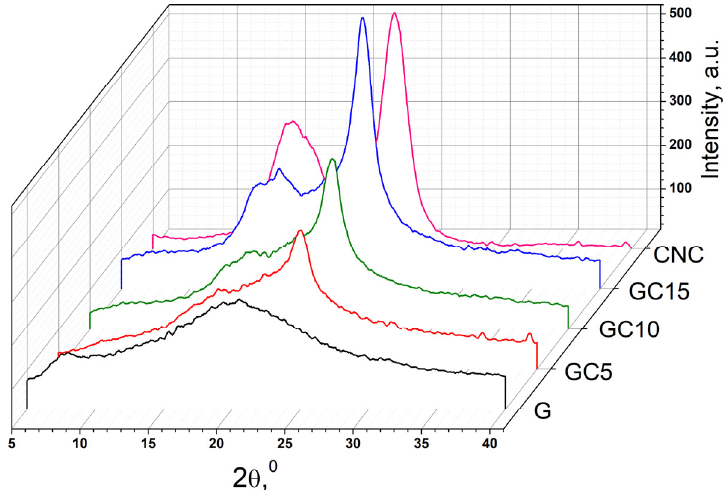
Figure 3. X-ray diffraction (XRD) patterns of gelatin, CNC and gelatin-based nanocomposite films. Gelatin films present a broad signal at 2 θ of 20° assigned to the high content of amorphous faction and to the distance between adjacent polypeptide strands of G [33] and a small band at 7.7° assigned to triple-helix crystalline structures [32]. CNC diffractogram presented typical signals of cellulose I, such as: 15.2° signal assigned to the (1–10) plane, 16.4° signal assigned to (110) plane, 20.3° signal corresponding to (102) plane and 22.6° signal assigned to the (200) crystallographic plane [23,34]. The signals from 16.4° 2 θ and 20.3° 2 θ merged with the ones from 15.3° 2 θ and 22.6° 2 θ , being almost unnoticeable [35].